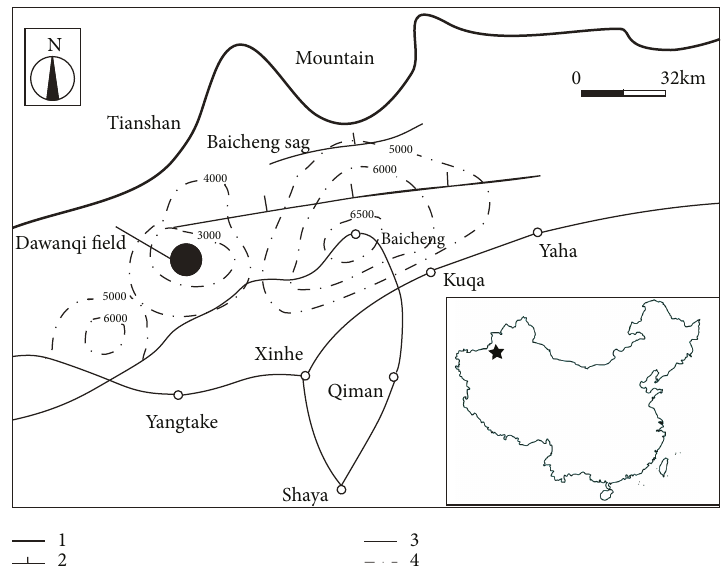
Figure 1: Location of Dawanqi fi eld (redrawn from Yang et al. (2006)). (1) Kuche Depression border, (2) fault, (3) railway, and (4) isolines (m) of the top of the Baicheng sag structure.